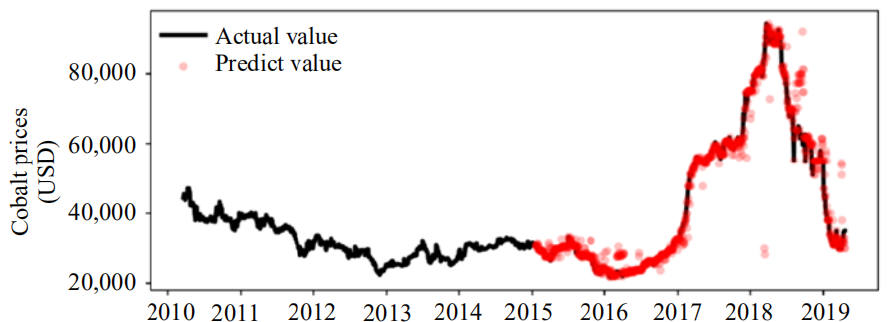
Figure 3. Comparison of predictive and actual nickel price.